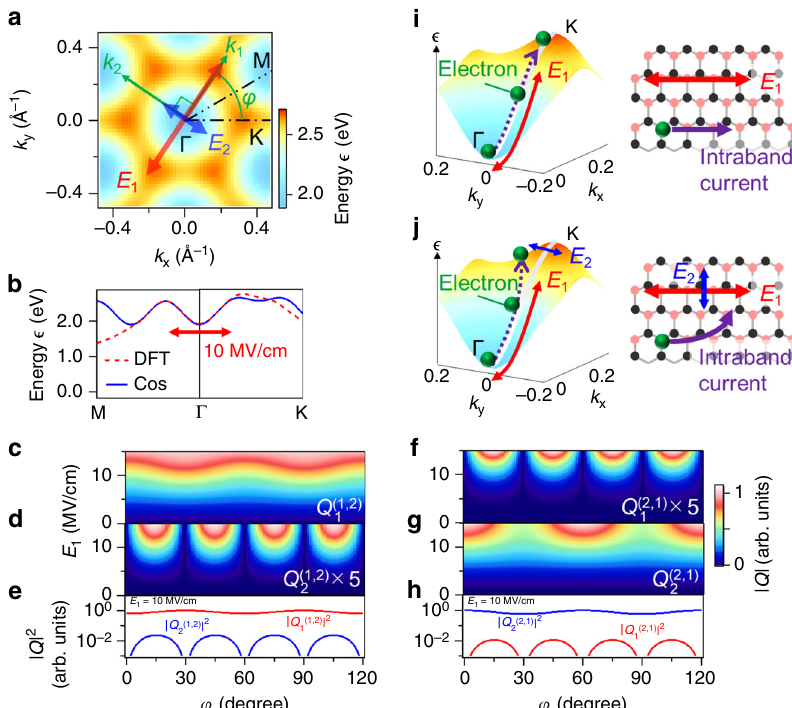
Fig. 4 Calculation model that considers 2D electron motion and the theoretical results. a 2D band dispersion of the fi rst conduction band modeled by employing a cosine function. b Comparison of the band structures obtained by density-functional theory (DFT) and the model that uses a cosine band structure. The red arrow indicates the region where the electric fi eld with E 1 = 10 MV/cm is able to drive the electrons. c – h Q i (1,2) and Q i (2,1) ( i = 1,2) as functions of E 1 and φ calculated by using Eq. (2). i Schematic of the motion of electrons driven by a single linearly polarized laser fi eld in k -space and real space. j Schematic for excitation with two orthogonal laser fi